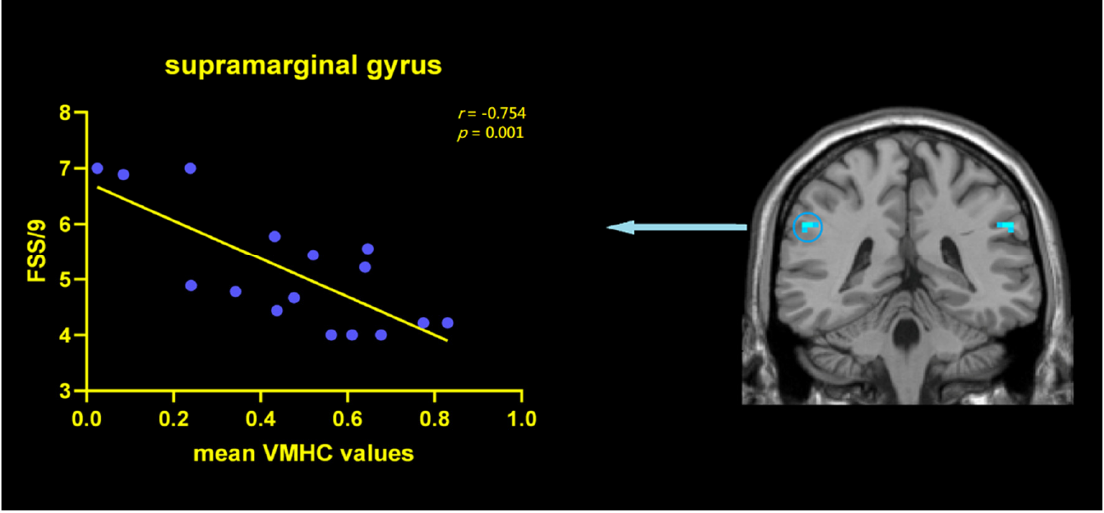
Figure 3. Correlations between VMHC values in SMG and FSS/9 scores within the PDF patients. Scatterplots demonstrated that there was a significant negative correlation between the mean VMHC values in the SMG (r = − 0.754, p = 0.001) and FSS/9 scores in PDF patients. Abbreviations: VMHC: voxel-mirrored homotopic connectivity; FSS: fatigue severity scale; SMG: supramarginal gyrus;